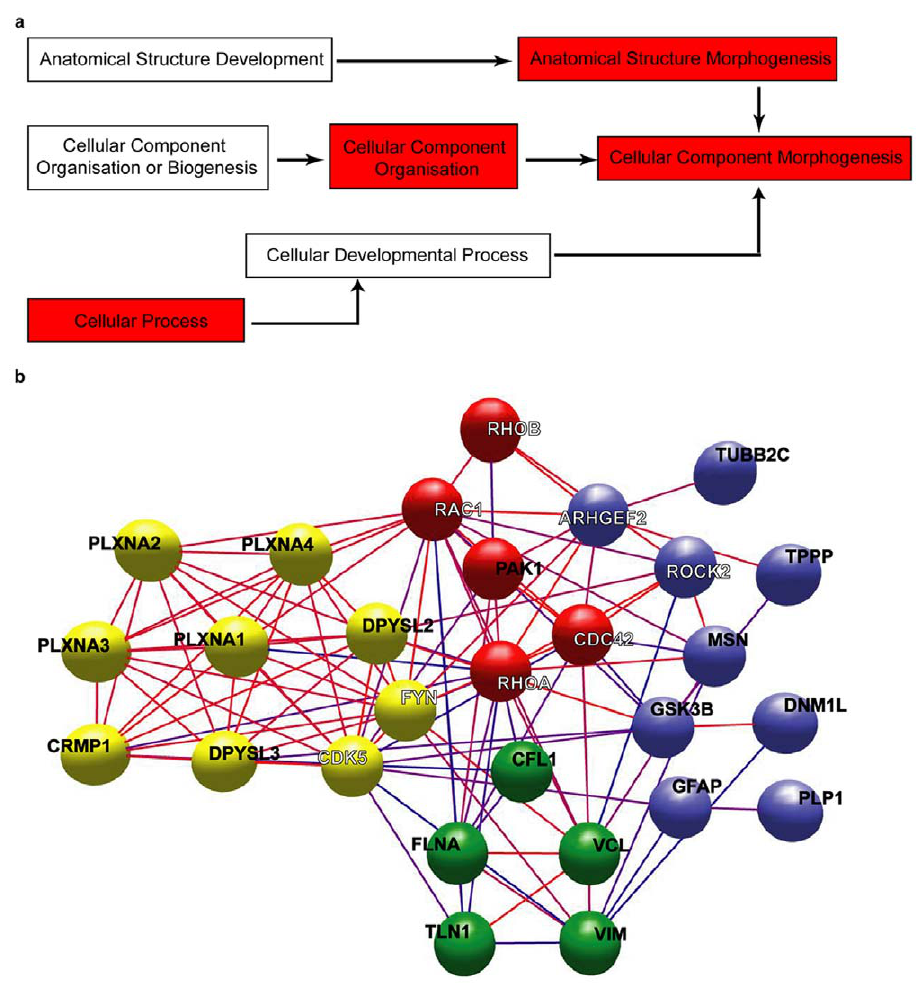
Figure 4. Functional analysis of proteins enriched in the human PSD. a. Ontology hierarchical tree leading to the Biological Process ‘Cellular Component Morphogenesis’. In red are the terms significantly enriched in proteins abundant in the human PSD. b. Molecular interaction map of proteins from the human PSD that belong to the Biological Process ‘Cellular Component Morphogenesis’ (CCM) or are known to be involved in semaphorin signaling. Only CCM proteins enriched in the human PSD are considered. Some proteins related to semaphorin signaling are not enriched in either species, these are identified with a white name. Proteins highly interconnected are represented in clusters of different colors. Clustering was done using the Markov Clustering Algorithm (MCL) in BioLayout Express 3D [24]. Node edges are coloured according to a confidence score, from red (100% confidence) to blue (40% confidence).